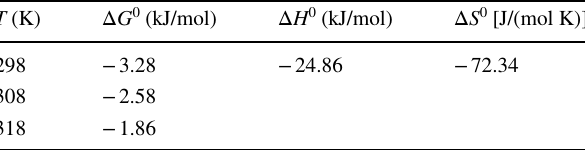
Table 4 Thermodynamic parameters at different